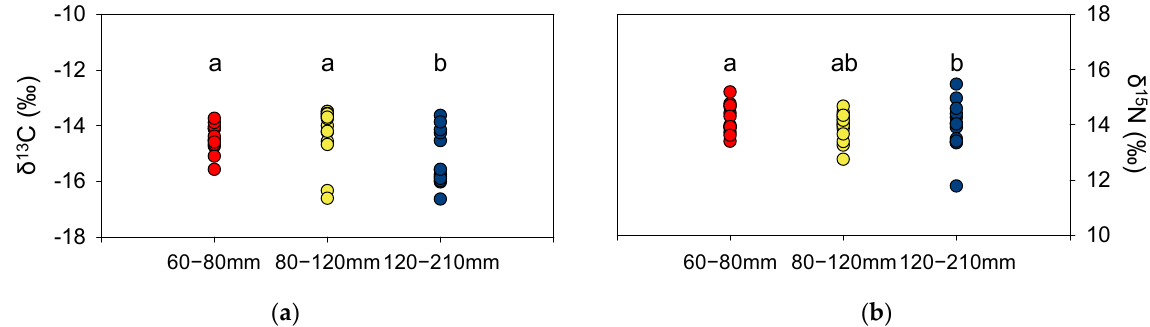
Figure 2. δ 13 C ( a ) and δ 15 N ( b ) values of P. argentata classified by their TL (mm). The letters indicate significant differences among size classes ( p < 0.05 for δ 13 C, and p > 0.5 for δ 15 N).